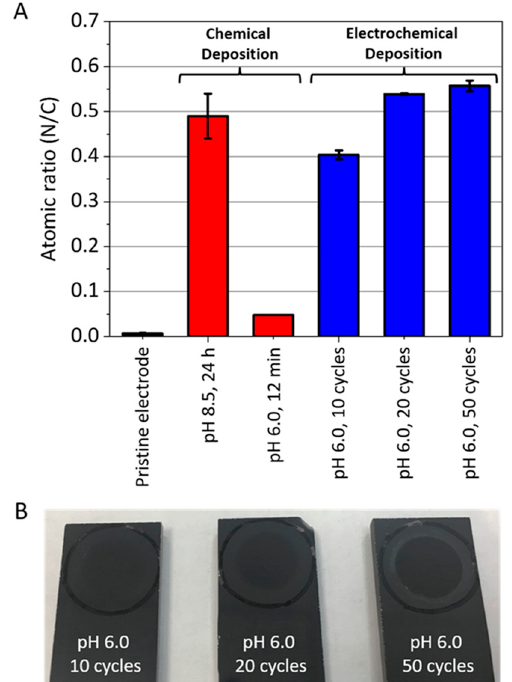
Figure 3. ( A ) Average nitrogen-to-carbon (N / C) elemental ratios acquired using X-ray photoelectron spectroscopy (XPS)on a pristine carbon electrode before and after chemical or electrochemical deposition of aminomalononitrile (AMN)-based films ( n = 3, error bars represent standard deviation). All coatings were deposited in the presence of 10 mg × mL − 1 AMN. Electrochemical deposition was performed with cyclic voltammetry (CV) at a scan rate of 50 mV × s − 1 . ( B )Pictures of the coatings obtained on carbon electrodes after different number of CV scans performed at pH = 6.0 and at a potential sweep rate of 20 mV × s − 1 . Reproduced from Reference [31] with authorization.